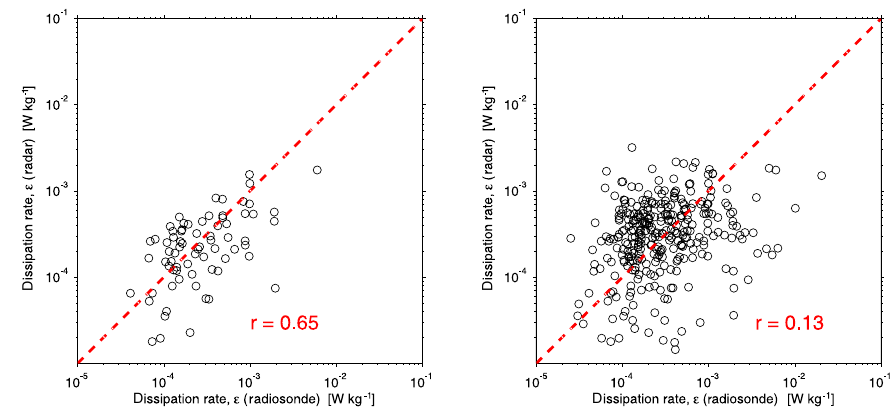
Figure 6. Scatter plots of the turbulent energy dissipation rates derived from the simultaneous measurements with radiosondes and radar. Left panel: the results derived based on the measurements during two flights on 1 July 2013 (i.e. the profiles shown in blue and red in Fig. 5). All turbulent layers, including both significant and non-significant ones, from radiosondes are included. The dashed line indicates an expected linear relation between them. In addition, we show the corresponding correlation coefficient r = 0 . 65, which is highly significant, i.e. well above the 99.9% level. Right panel: the results derived from all the nine flights with the simultaneous measurements with MAARSY. Here, the corresponding correlation coefficient is at r = 0 . 13, which is not